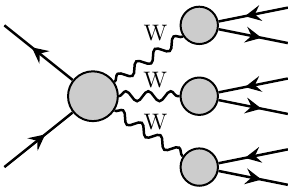
Figure 5. Structure of diagrams contributing to the factorizable NLO virtual corrections in the TPA. The gray circles indicate either a tree-like substructure or a loop subdiagram.